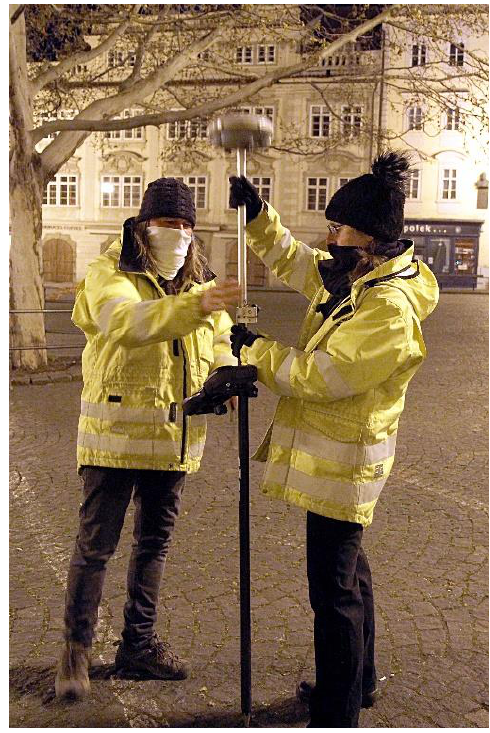
Figure 14. Trimble R8s at the Lesser Town Square in the times of coronavirus.